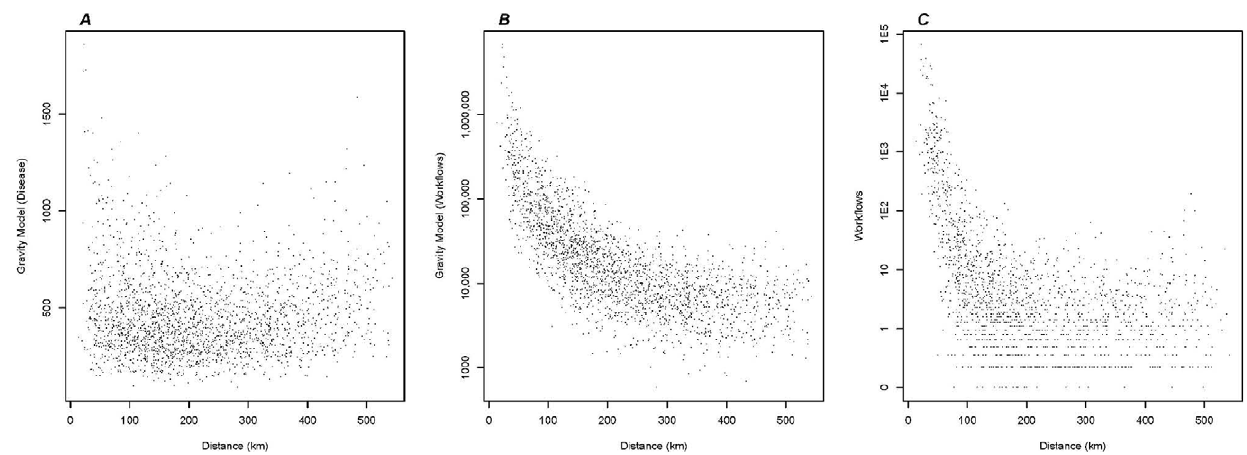
Figure 6. Correlation of gravity model and workflows with distance. A) Each point represents the distance between two counties as a function of the gravity model fitted to disease for the pair of counties. B) Each point represents the distance between two counties as a function of the gravity model fitted to workflows for the pair of counties (y-axis log10 scale). C) Each point represents the distance between two counties as a function of the workflows for the pair of counties (y-axis log 10 scale).